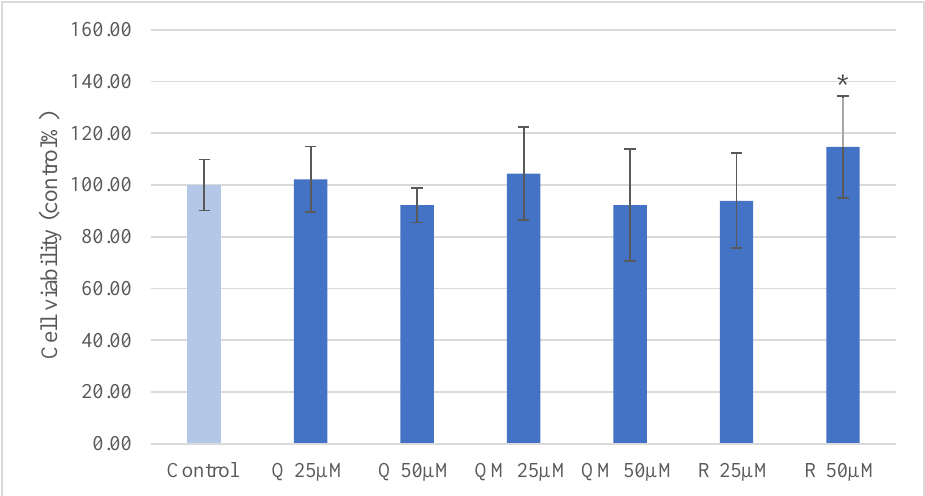
Figure 2. Viability of porcine intestinal epithelial cells (IPEC-J2) after treatment with different concentrations (25 µM and 50 µM) of quercetin (Q), 3-o-methylquercetin (QM) and rhamnazin (R). Data are shown as means with standard deviations ( n = 6/group; * p < 0.05) in control percentage.